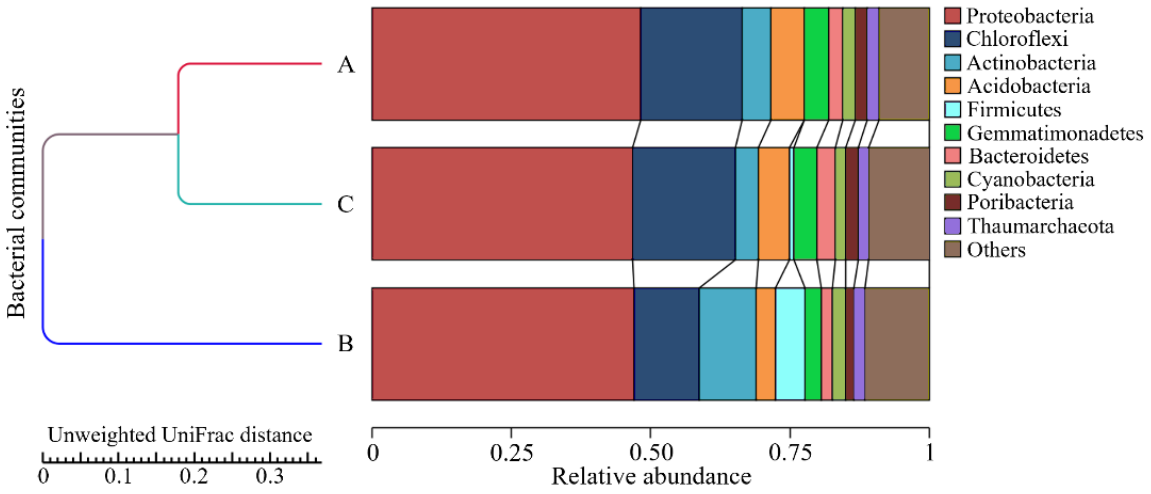
Figure 6. A relative abundance stacked bar chart of the top ten dominant phyla detected in the sponge-associated bacterial diversity profiles of this study. A, A. aaptos prokaryotic community of Bidong Island; B, A. aaptos prokaryotic community of Redang Island; C, X. muta prokaryotic community of Bidong Island.